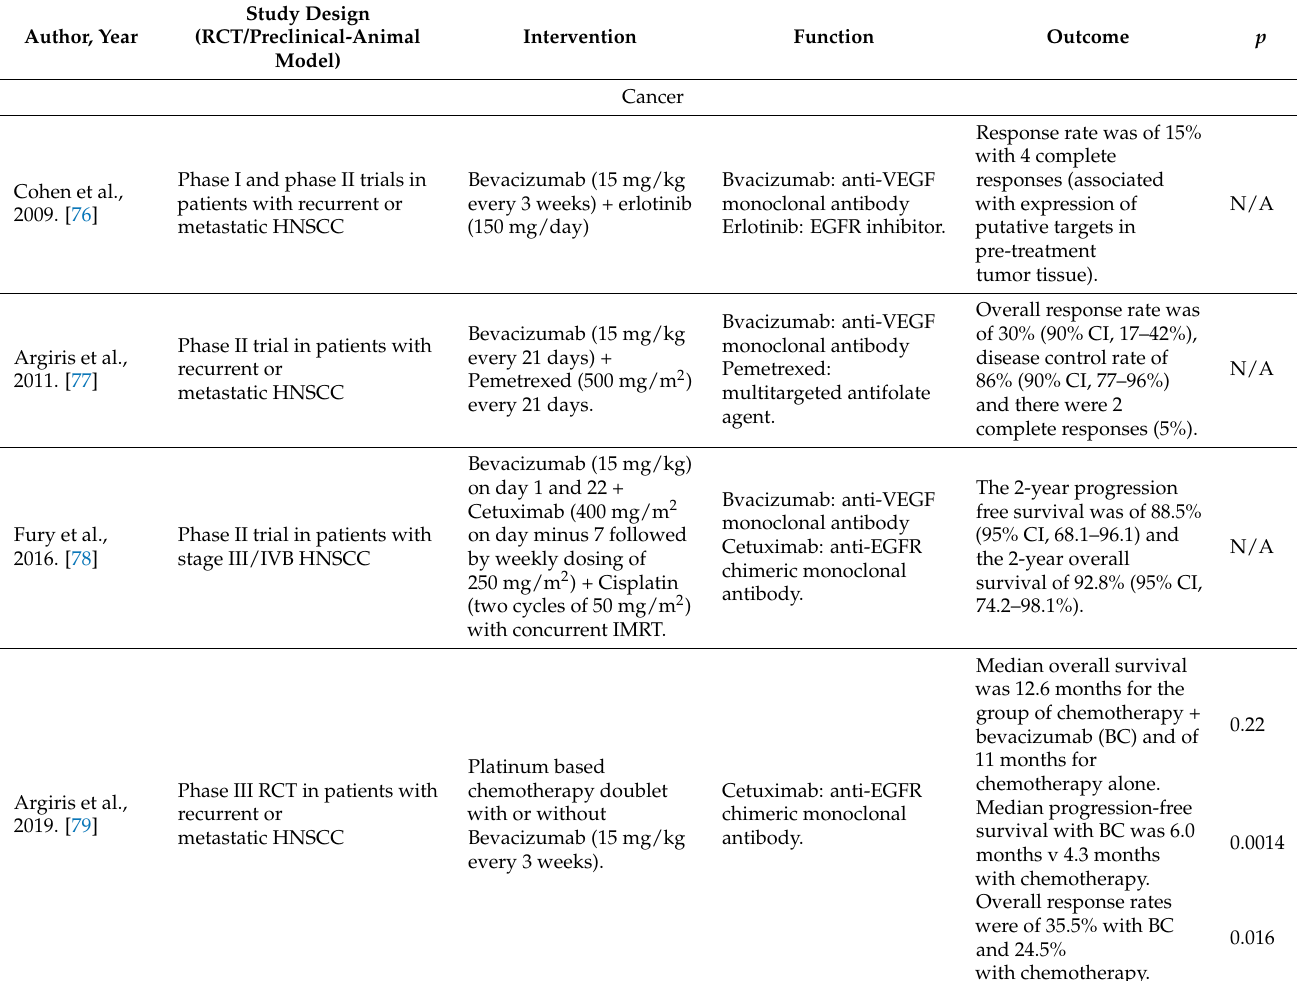
Table 2. VEGF pathway therapeutics in oral non-communicable